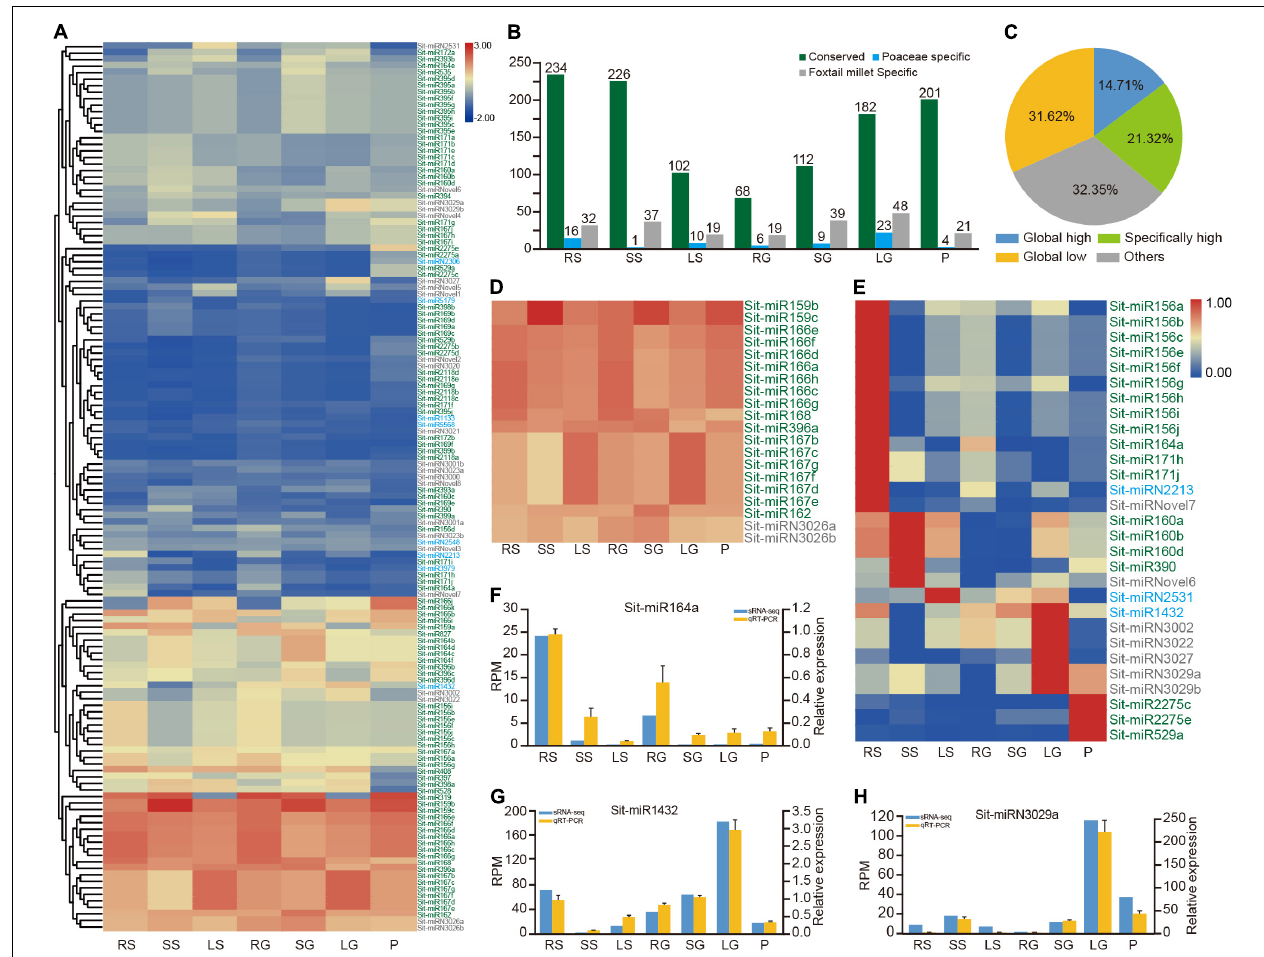
FIGURE 2 | Dynamic expression profiles of miRNAs in foxtail millet. (A) The average expression profile of 136 miRNAs in seven tissues. Green, blue, and gray coloring miRNA IDs represent conserved, Poaceae-specific, and foxtail millet-specific miRNAs, respectively. RS, SS, and LS indicate root, stem and leaf tissues at the shooting stage, respectively. RG, SG, LG, and P indicate root, stem, flag leaf, and panicle tissues at the grain filling stage, respectively. (B) Average expression values of conserved, Poaceae-specific and foxtail millet-specific types of miRNAs in all samples. (C) The pie chart shows the proportion of four expression patterns of miRNAs. (D) Global highly expressed (housekeeping) miRNAs in seven tissues. (E) Highly expressed miRNAs in only one specific tissue. (F–H) qRT-PCR results of Sit-miR164a, Sit-miR1432 and Sit-miRN3029a compared with the sRNA-seq result, respectively. RPM, reads per million; qRT-PCR, real-time quantitative reverse transcription PCR; sRNA, small